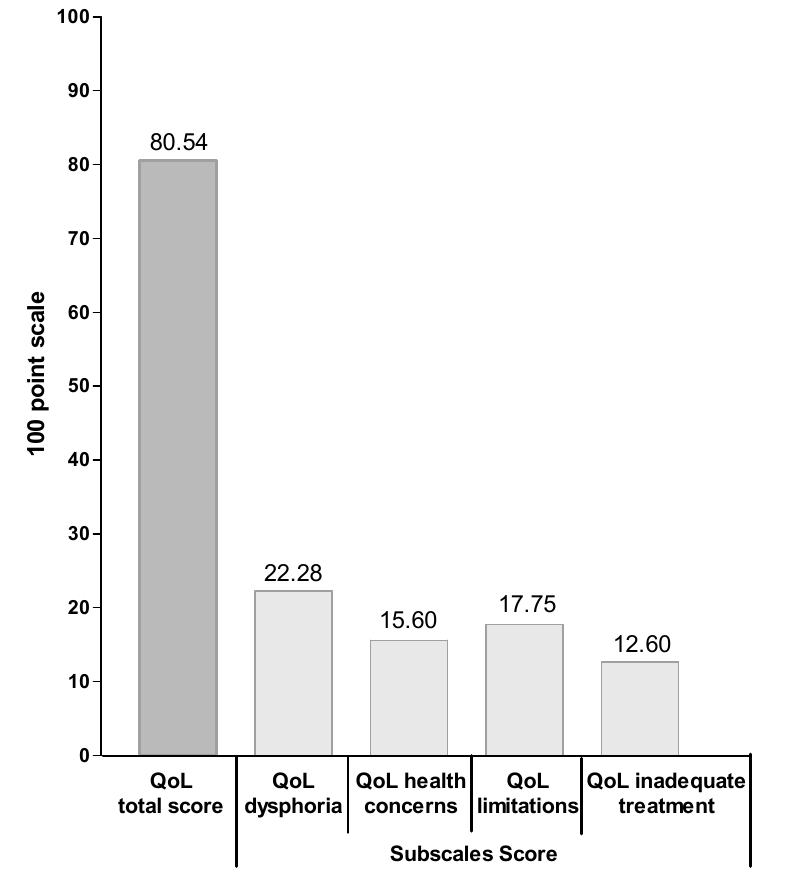
Figure 1. CD-specific Quality of Life Scale (CD-QoL) score and subscale scores.